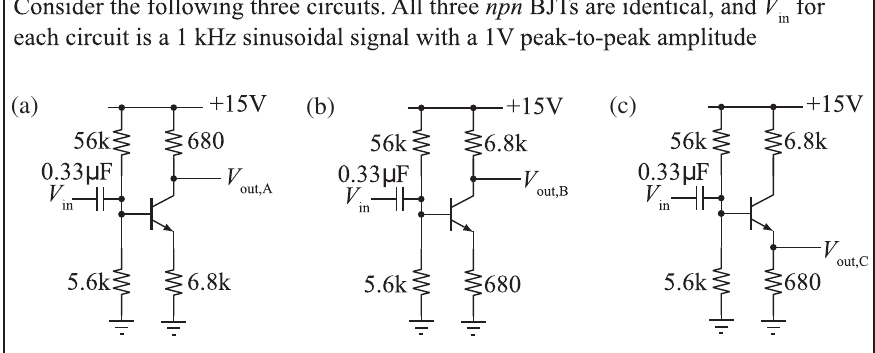
FIG. 3. Three amplifier comparison task. Note that the text has been slightly abridged and paraphrased and that explanations were